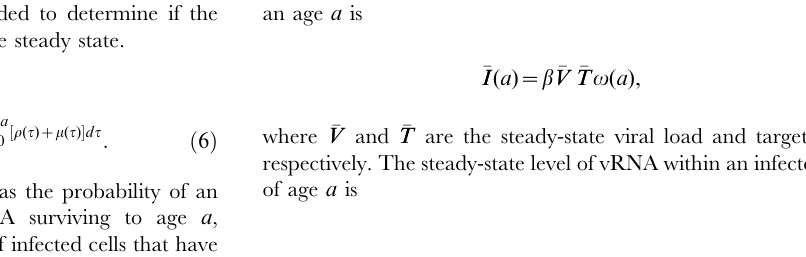
Table 1. Parameter values with standard errors in parenthesis estimated by fitting the standard biphasic model to viral load data.